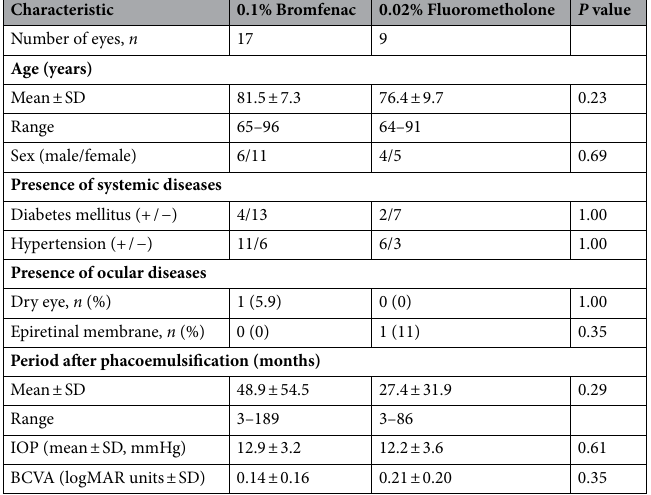
Table 1. Patient demographic data. Statistical comparisons between the bromfenac and fluorometholone groups were performed using Mann–Whitney U and Fisher’s exact tests. SD standard deviation, IOP intraocular